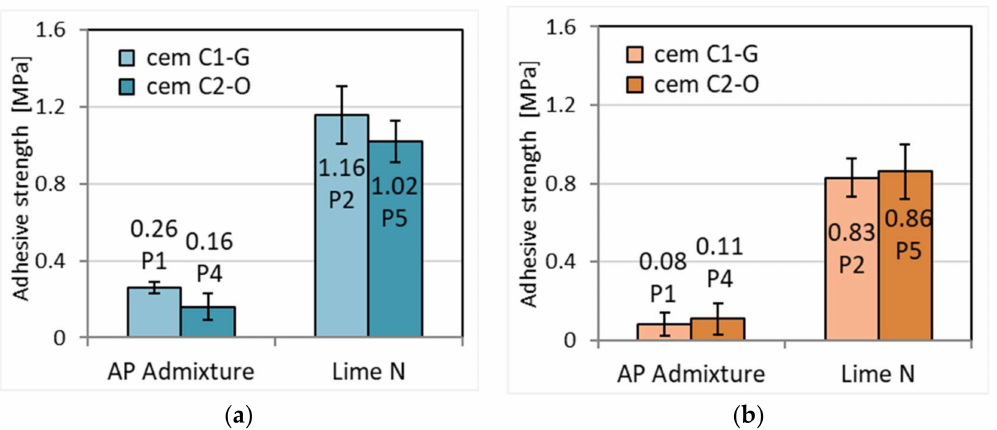
Figure 12. Adhesive strength to ceramic base of plasters ( a ) and masonry mortars ( b ).